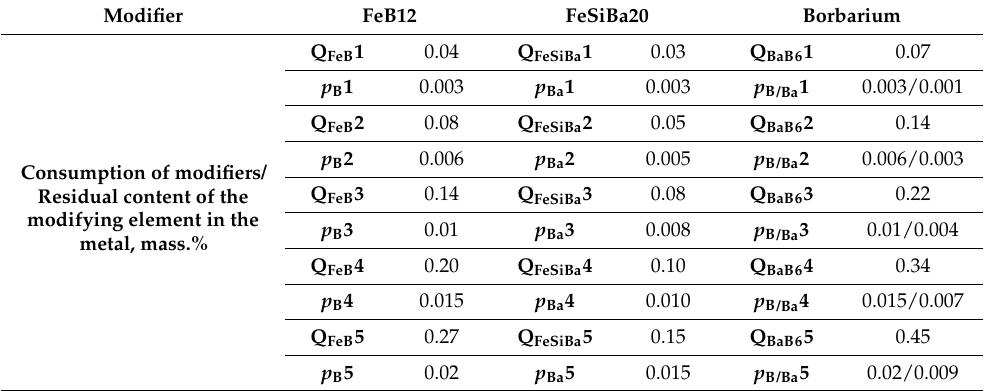
Table 2. Doses of modifiers and estimated residual content of modifying elements in metal. Modifier FeB12 FeSiBa20 Borbarium